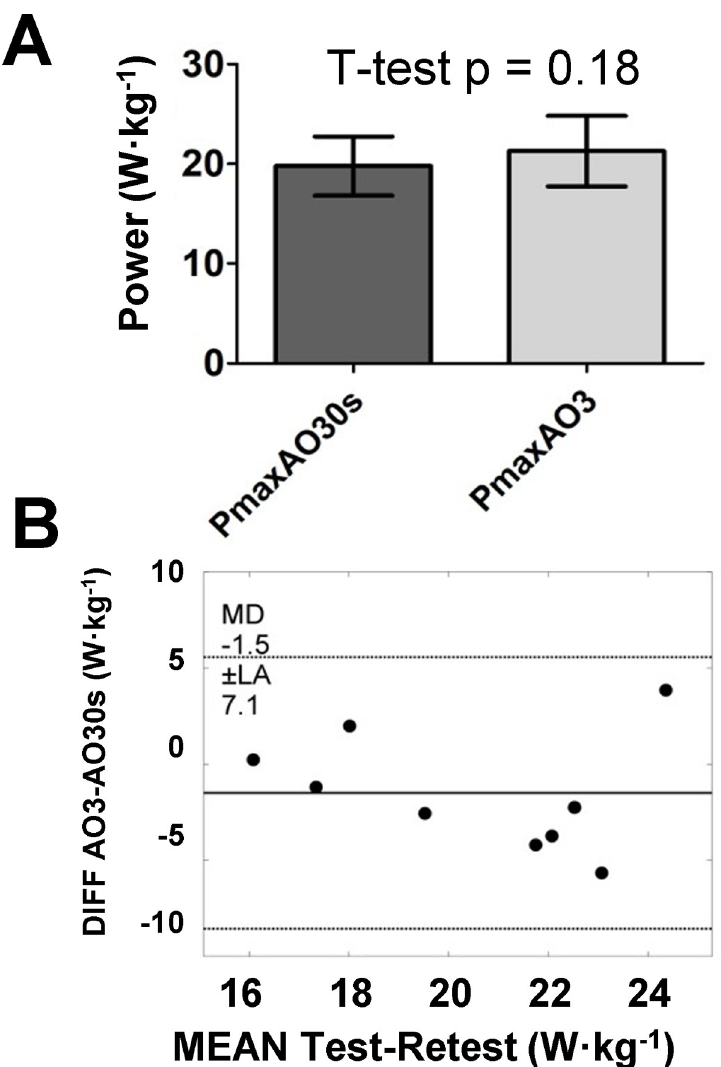
Fig 4. Comparison between Pmax from AO30s and AO3 (A), with the respective Bland-Altman analysis (B); (n = 9). PmaxAO30s –maximum power during the 30-s all-out; PmaxAO3 –maximum power during the AO3. to 0.99 (1,7). On the other hand, the WEP from AO3 performed on the cycle ergometer returns CV around 21% despite ICCs ranging from 0.76 to 0.98 (7,8), which is closer to those presented here. AO3 reliability was also measured for the rowing ergometer, returning test- retest CV of 9% for EP and ICCs of 0.78 for EP and 0.62 for WEP [14]. With few studies focused on the AO3 application for running and controlling external load only based on velocity (23,24), Gama et al. [33] were the first to study the AO3 reliability on a non-motorized treadmill measuring mechanical power. Based on the data from Gama et al. [33], reliability is improved when measurements are based on power rather than on force or velocity. Our results confirm the intra-subject reliability of Pmax, WEP, and EP for running on a non-motorized treadmill. This assumption is based on ICC and TE analysis. However, when considering the magnitude of the limits of agreement and CV, one should consider the individual variability for these parameters when studying training adaptations. Despite our